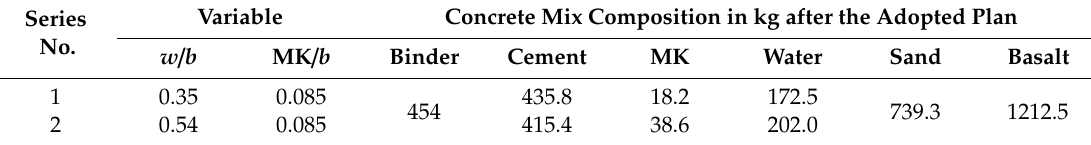
Table 1. Concrete mix